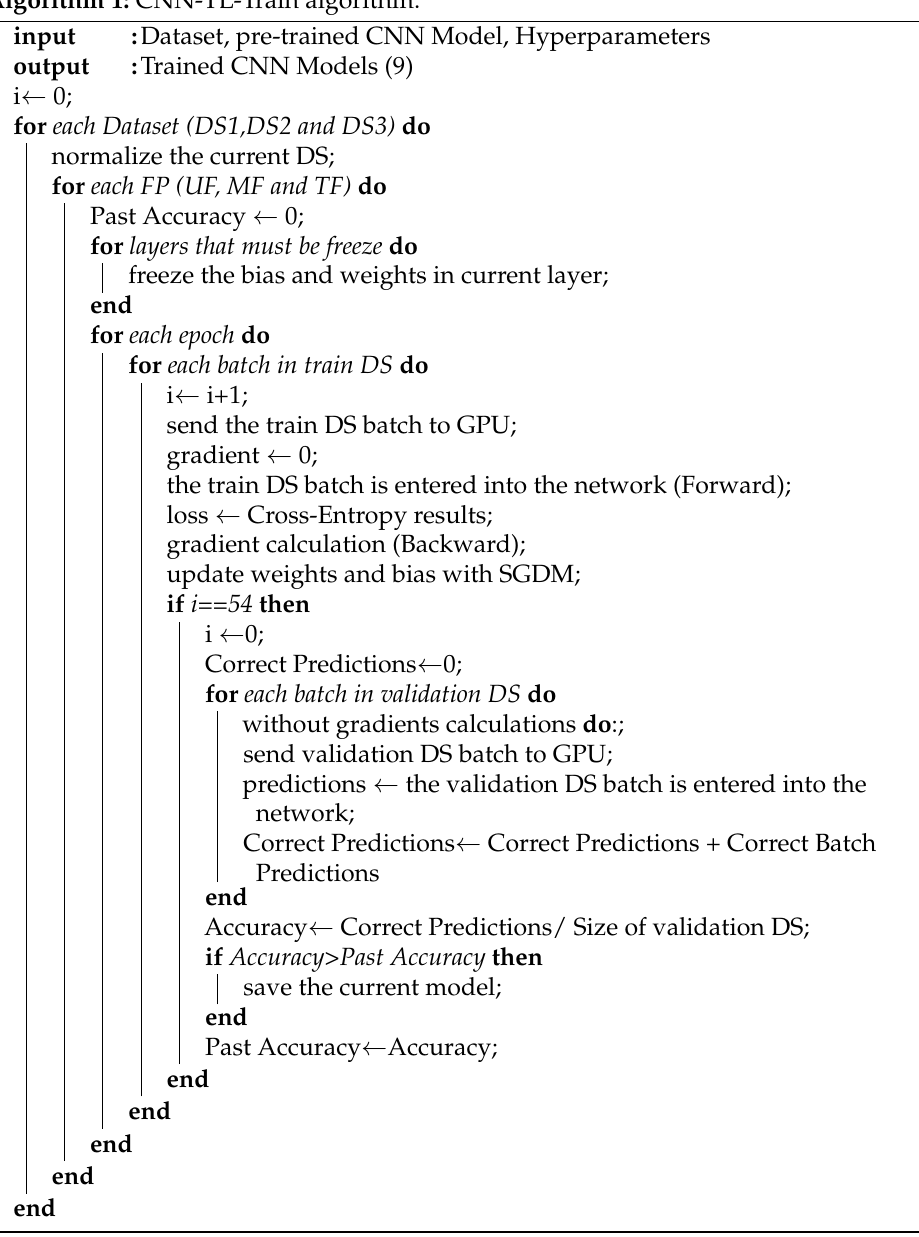
Algorithm 1: CNN-TL-Train